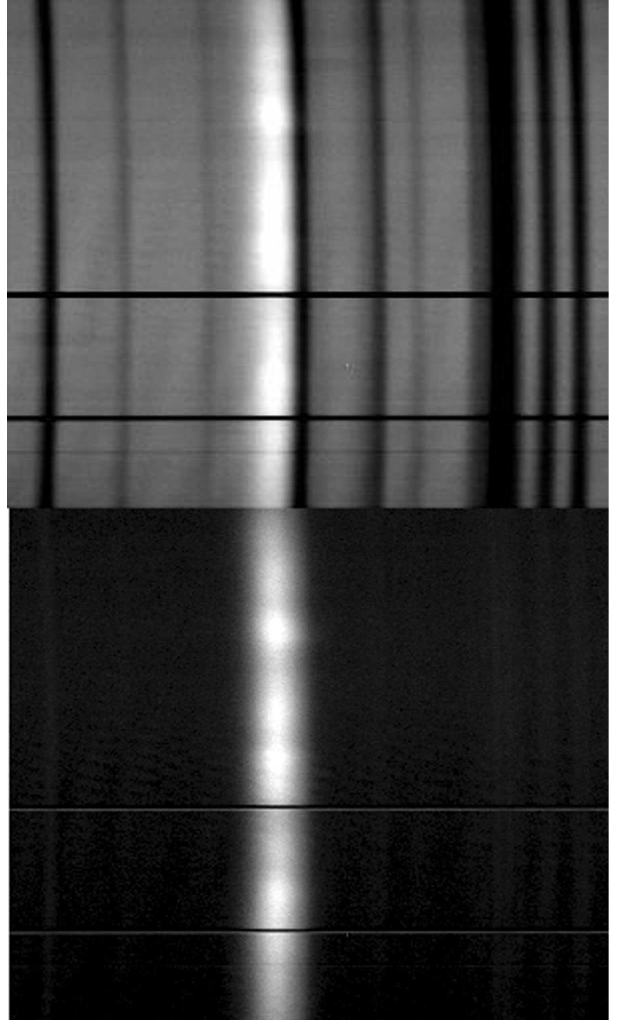
Fig. 2. Average image of the spectrum taken above the E-limb at a distance of 1.5 0 from the limb (this position of the slit is barely seen in Fig. 1). At the top, a raw spectrum; at the bottom, the coronal spectrum after removing the parasitic background light and correct- ing the spectrum for geometric distortion effects. Note the rather large inhomogeneities of coronal line emissions along the length of the slit. The hair lines are also kept (two dark lines crossing the spectra) to show a distance of 56Mm in the corona along the slit.